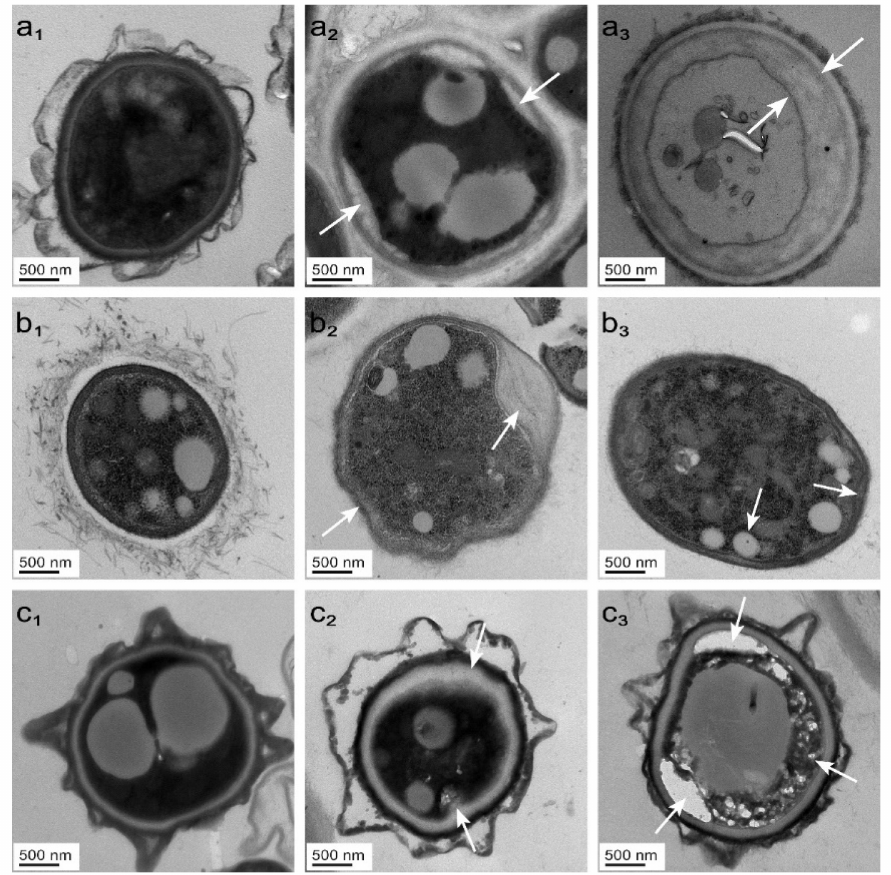
Figure 6. Effect of dodecylpyridinium chloride treatment on the microscopy of bamboo mycorrhizal cells (( a – c ) PC, TV, and AN, respectively; subscripts ( 1 – 3 ) are control, MIC, and MFC,